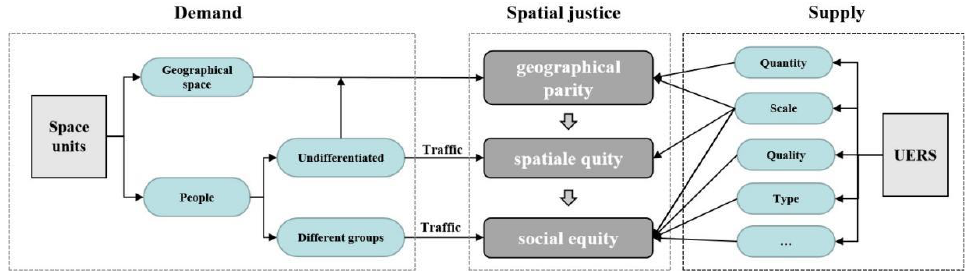
Figure 1. Evolution diagram of spatial justice theory.